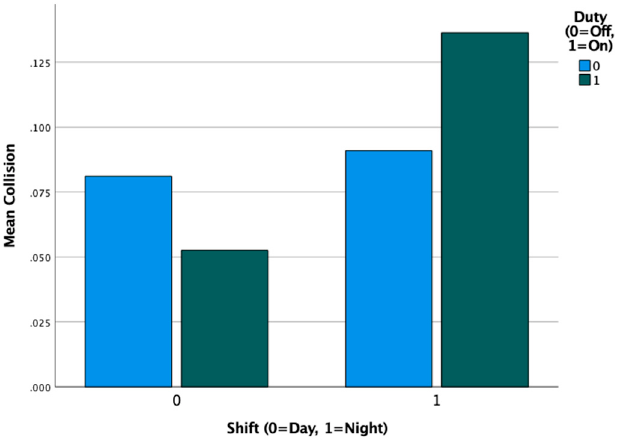
Figure 4. Simulator collisions by shift type (day vs. night) and shift duty (on vs. off). No significant interactions between shift type (day vs. night) and shift duty (on-duty vs. off-duty) were observed for any outcome variables, indicating that night shift nurses were at greater risk for collision, even following days off work.